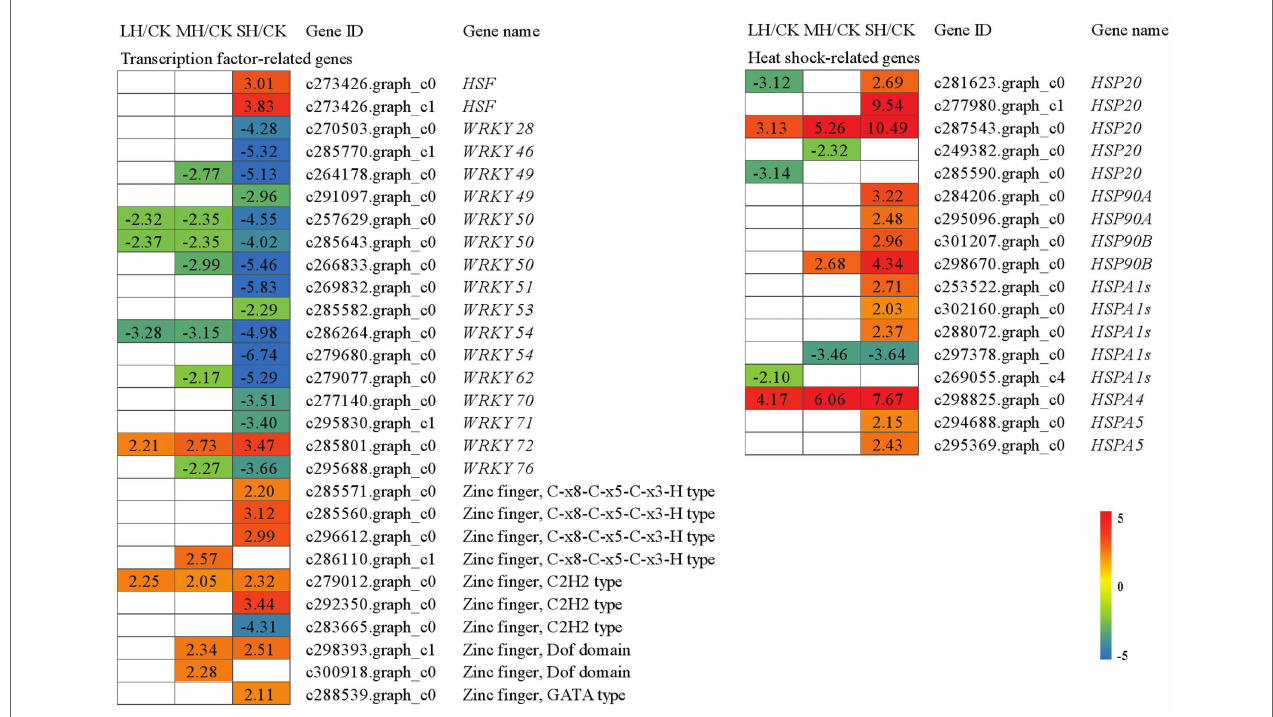
FIGURE 3 | Transcription factor (TF) and heat shock protein (HSP) genes identified in the RNA-seq that showed expression changes during temperature treatments. The numbers in the rectangles indicate the fold-changes (FCs) of the